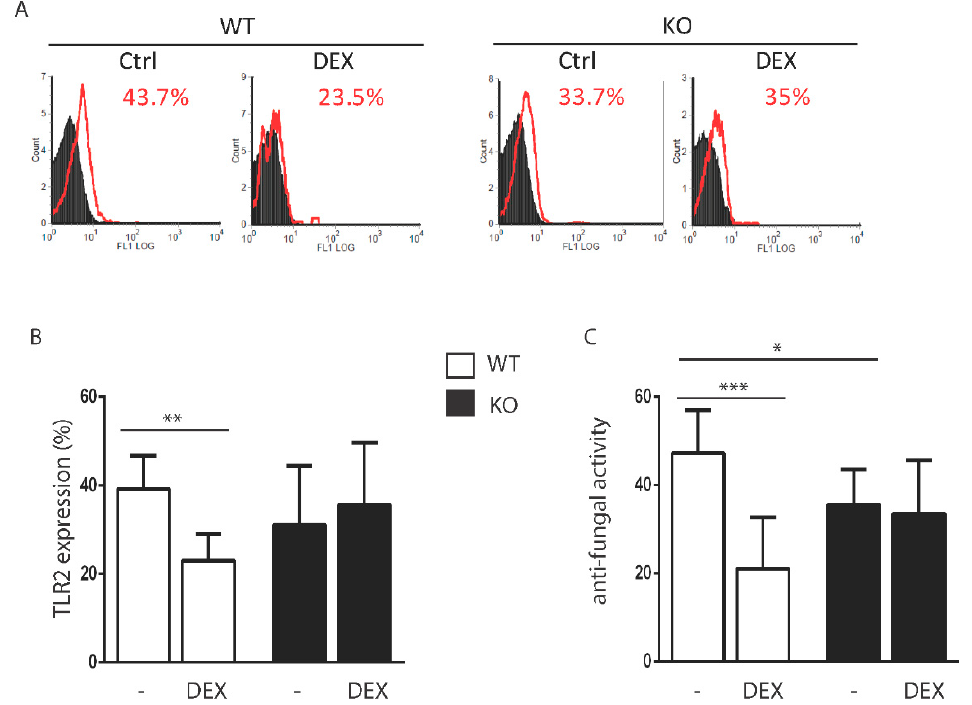
Figure 1. TLR2 expression and neutrophil function was regulated by glucocorticoids via GILZ. ( A ). Flow cytometry evaluation of Toll-like receptor 2 (TLR2) expression in neutrophils isolated from wild type (WT) and GILZ-Knock-out (KO) mice following 3 h treatment with dexamethasone (DEX). Isolated neutrophils were analysed for TLR2 expression (red line) as the percentage of positive cells; the black histogram represents the isotypic control. A representative experiment is shown. ( B ). TLR2 expression on neutrophils. ( C ). Anti-fungal activity of WT and KO neutrophils, as evaluated in vitro against Candida albicans . Mean value of three independent experiments ± SD. N = 2–3/group. * p < 0.05; ** p < 0.01; *** p <